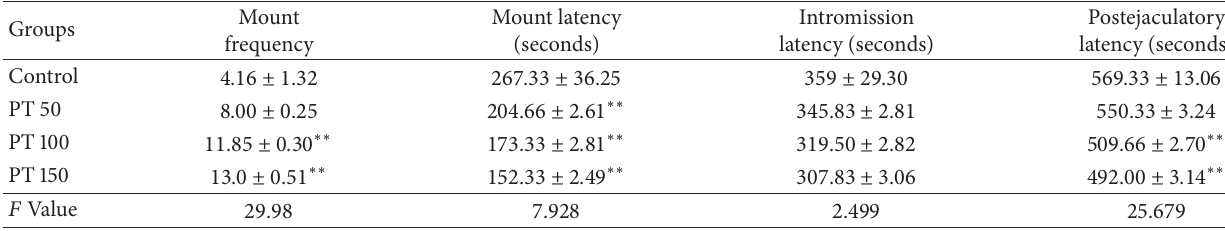
Table 3: Effect of ethanolic extract of plants on sexual behavior.